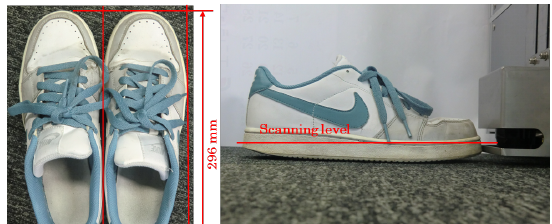
distance, the angle of the footmark ( α , direction of foot) is set from 15 to 165 deg (15, 30, 45, 60, 75, 82.5, 90, 97.5, 105, 120, 135, 150 and 165 deg). In each angle, the foot is stepped 10 times in two conditions; (1) Forward direc- tion: the subject facing to the laser range scanner sets his hindfoot on C b , and (2) Backward direction: the subject at backward-lookingposturesetshisforefooton C b .Theshoe used in the experiment is a typical sports shoe in white with 100 mm in width and 296 mm in length as shown in Figure 18.